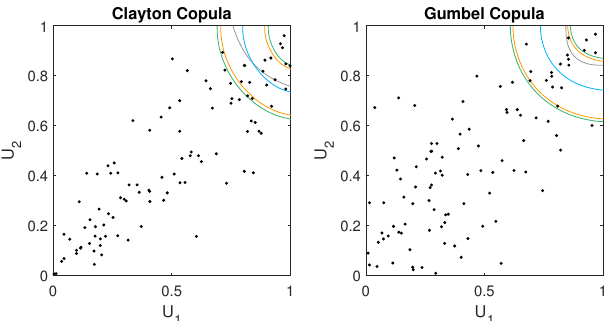
Figure 2. Example of the extended Chen et al. [15] approach. The blue line shows the estimated boundary of the multivariate quantile based on a kernel density estimated copula, the gray line shows the theoretical multivariate quantile boundary for p = 0.9. The orange and green lines depict the boundaries of the confidence region for α = 0.1 and α = 0.05, respectively. Left Panel: Clayton copula sample with θ = 3 (i.e., Kendall’s τ = 0.6) and n = 100. Right Panel: Gumbel copula sample with θ = 2.5 (i.e., Kendall’s τ = 0.6) and n =